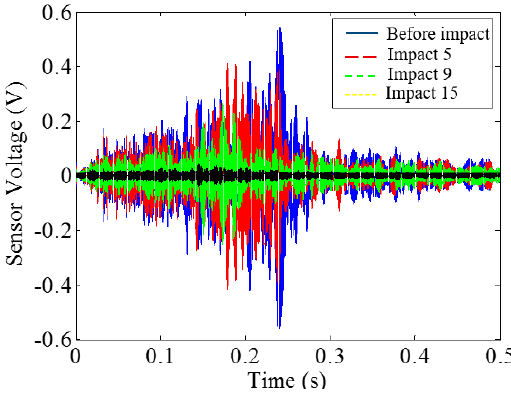
Figure 14. Time-domain signal received by SA sensor in PVA-ECC-2. Figure 14 . Time-domain signal received by SA sensor in PVA-ECC-2. Figure 14 . Time-domain signal received by SA sensor in PVA-ECC-2. Figure 14 . Time-domain signal received by SA sensor in PVA-ECC-2.